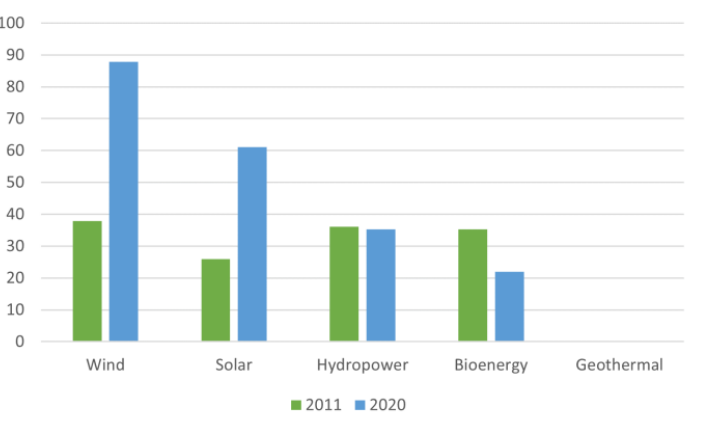
Figure 8. Renewable energy capacity in EU Member States of BSR in 2011 and 2020 [GW]. Source: own study based on [46].